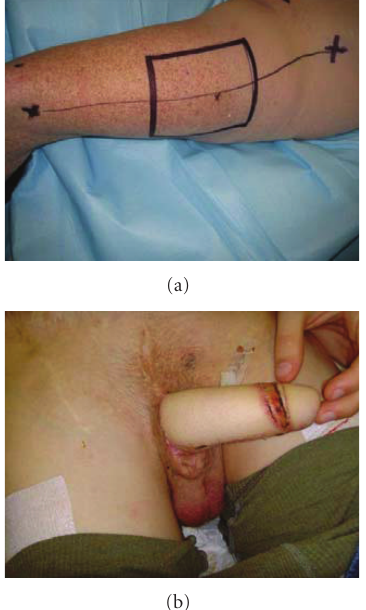
Figure 3: The anterolateral thigh flap. (a) Preoperative: the vascular pedicle is marked at the middle using Doppler-ultrasound. (b)